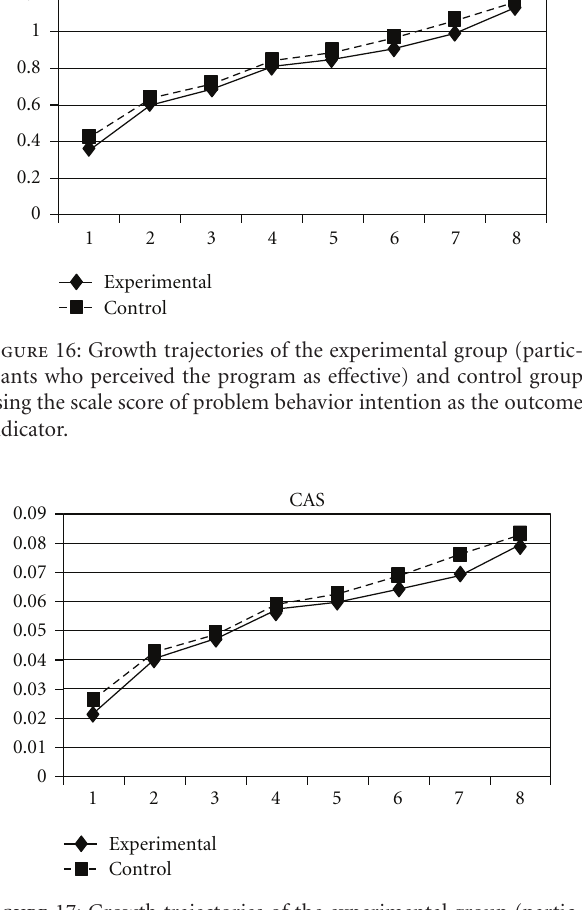
Figure 17: Growth trajectories of the experimental group (partic- ipants who perceived the program as e ff ective) and control group using the composite score of tobacco use and alcohol use as the outcome indicator.